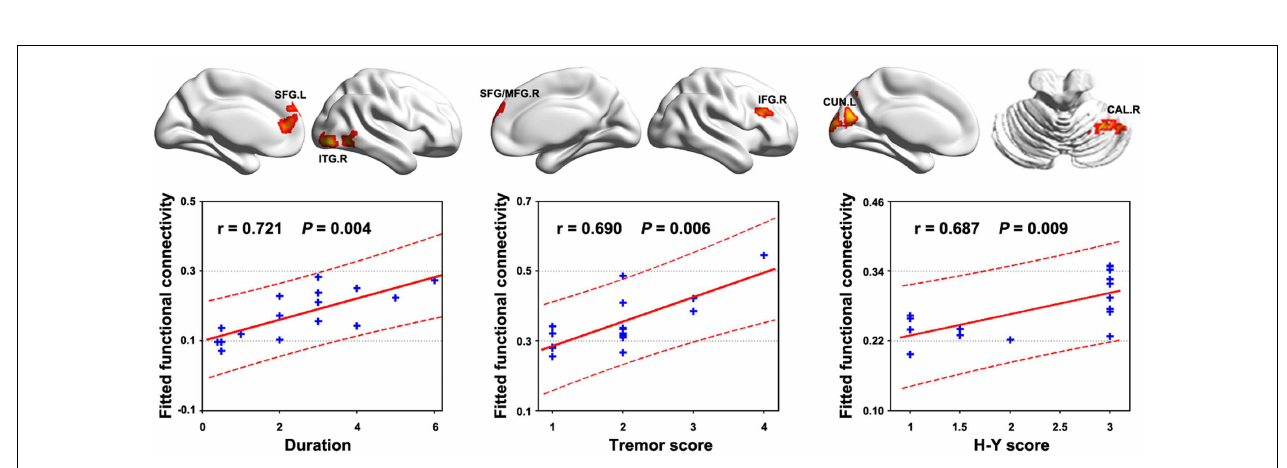
FIGURE 3 | Between-group differences in network efficiency . (A) Brain surface representation of the 50 ROIs showing abnormal connectivity in PD. (B) mean connectivity patterns among the 50 ROIs for the PD and NC groups